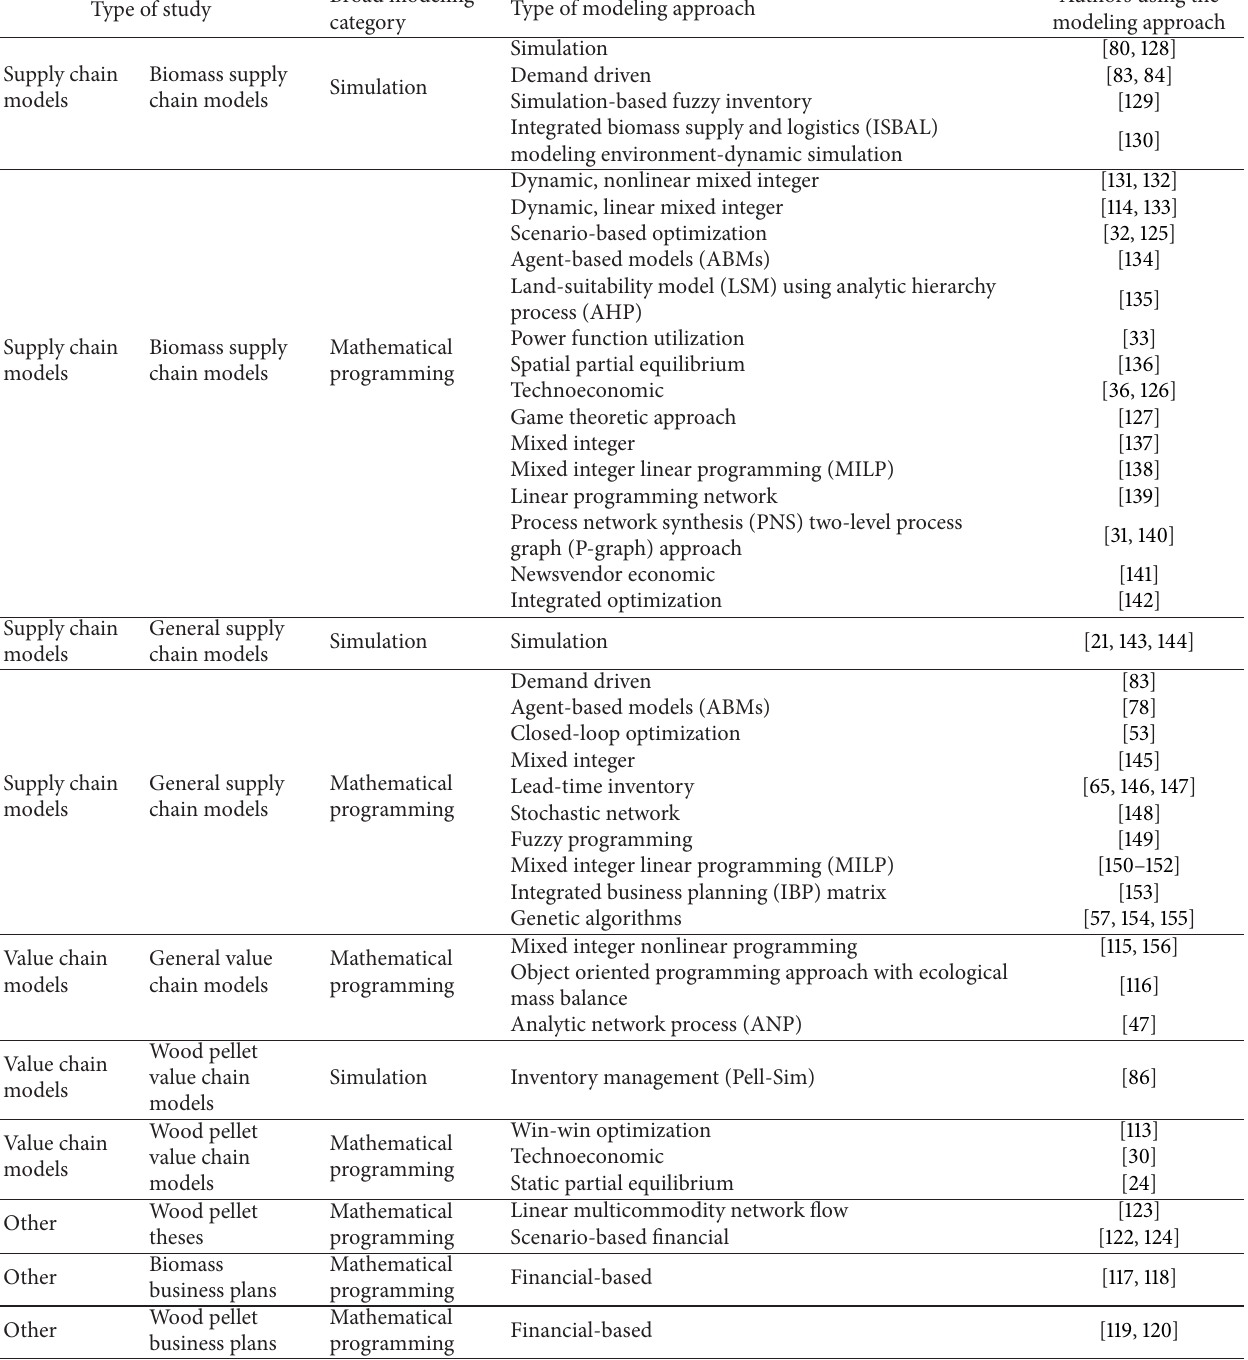
Table 2: Categorization of model types in reviewed